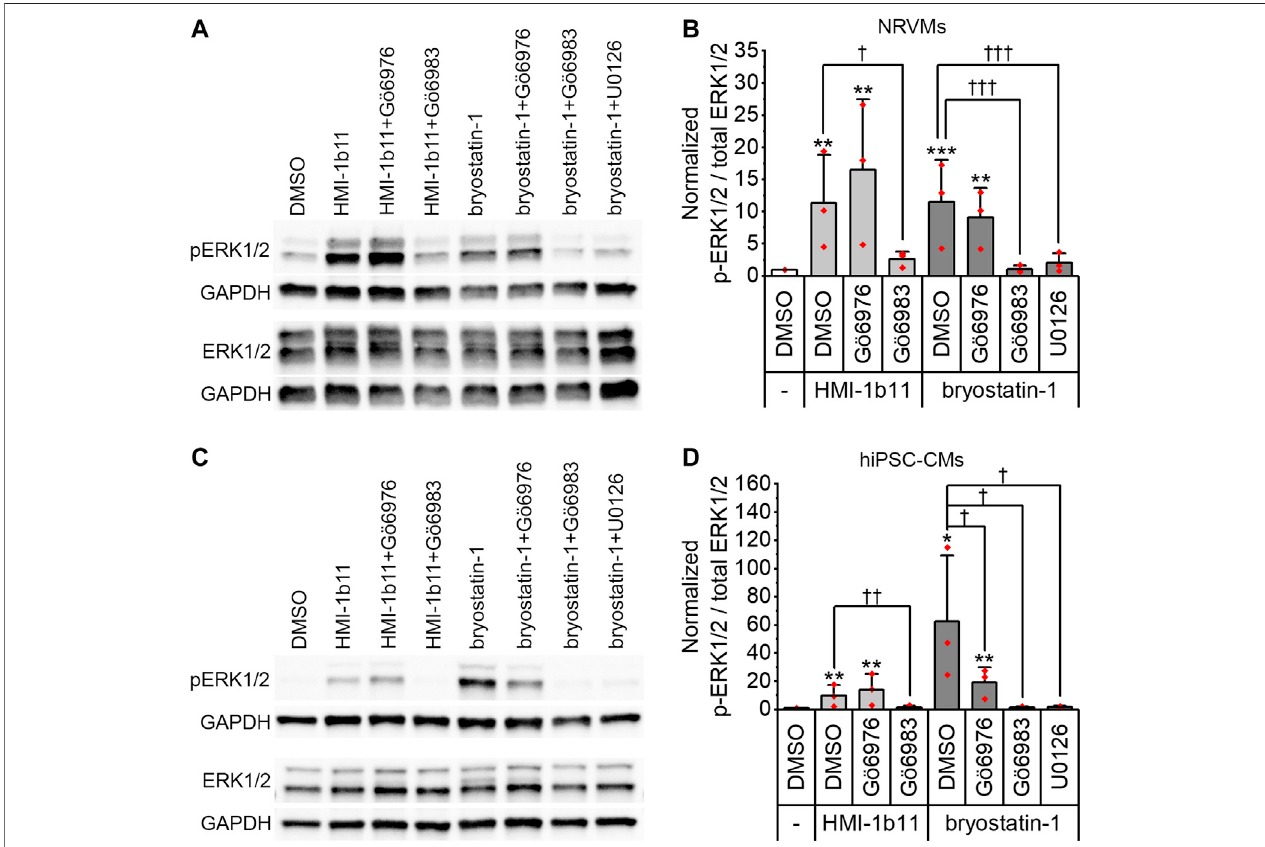
FIGURE 1 | Effects of PKC modulators on ERK1/2 phosphorylation. Cells were exposed to cPKC inhibitor (1 µM Gö6976), pan-PKC inhibitor (1 µM Gö6983) or MEK1/2 inhibitor (10 µM U0126) for 15 min, after which PKC agonists HMI-1b11 (at 10 µM) or bryostatin-1 (at 10 nM) were added for 30 min. (A) Representative immunoblots for NRVMs; (B) quanti fi cation of Western blots expressed as mean + SD of three independent experiments (cardiomyocytes from individual cell isolations) for NRVMs; (C) representative immunoblots for hiPSC-CMs (day 18 – 20); (D) quanti fi cation of Western blots expressed as mean + SD of three independent experiments (cardiomyocytes from individual differentiations) for hiPSC-CMs. The expression of phosphorylated ERK1/2 (p-ERK1/2) and total ERK1/2 were normalized toGAPDH,afterwhichtheratiowascalculatedandnormalizedtoDMSO.*** p < 0.001,** p < 0.01,* p < 0.05vs.DMSO; ††† p < 0.001, †† p < 0.01, † p < 0.05asindicated (Univariate ANOVA followed by student ’ s t-test for independent samples). The original full images of immunoblots are shown in Supplementary Figure S2 .